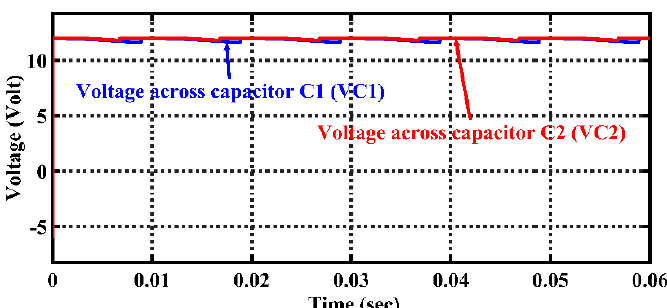
Figure 9. ( a ) Output voltage and current for dynamic change in modulation index and ( b ) total harmonics distortion (THD) in output voltage for symmetric configuration.